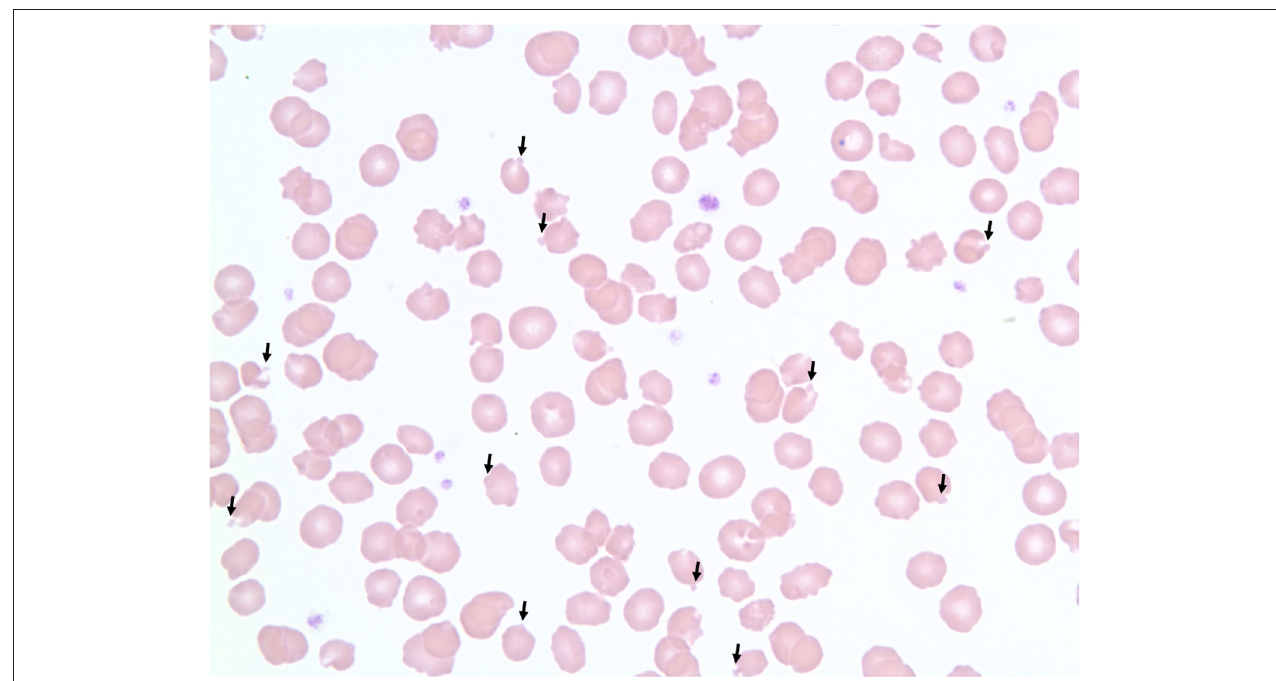
FIGURE 1 | 100 × magnification blood smear showing red blood cells with Heinz bodies in a cat after repeat propofol administration. Heinz bodies indicated with